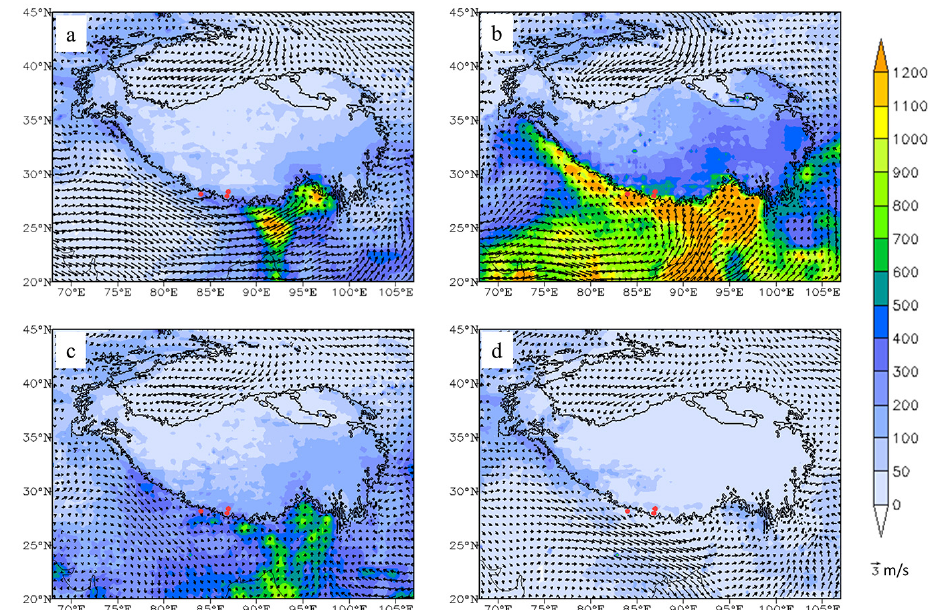
Fig. 2. Spatial distribution of TRMM-derived seasonal mean climatology of accumulated precipitation (mm) and wind at 850hPa over the Tibetan Plateau (a) March to May (MAM); (b) June to August (JJA); (c) September to November (SON); (d) December to February (DJF). The bold black line marks the geographic location of Tibetan Plateau, and the red dots indicate the locations of the three stations.